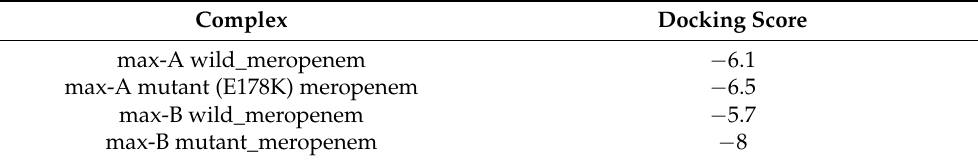
Table 13. Docking energy score in